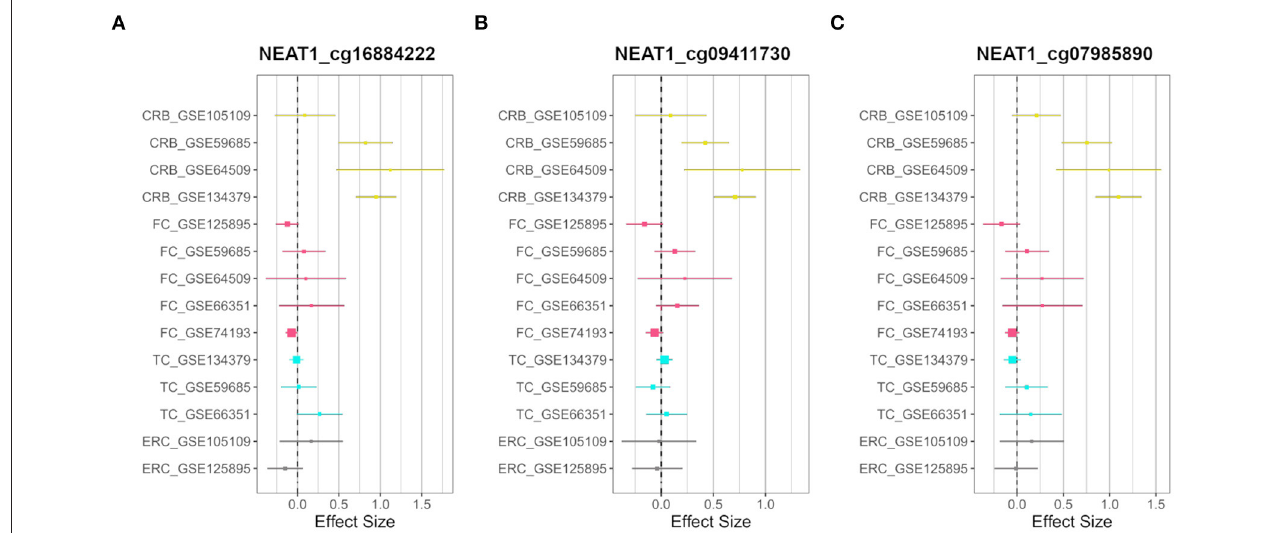
FIGURE 3 | CRB-specific sex-associated DNAm of NEAT1 gene. Forest plots of three CRB-specific sDMPs mapping in NEAT1 gene: (A) cg16884222, (B) cg09411730, (C) cg07985890. For each probe, effect sizes from the datasets used for our meta-analysis are reported, dividing them according to the four brain regions (CRB, yellow; FC, magenta; TC, cyan; ERC,